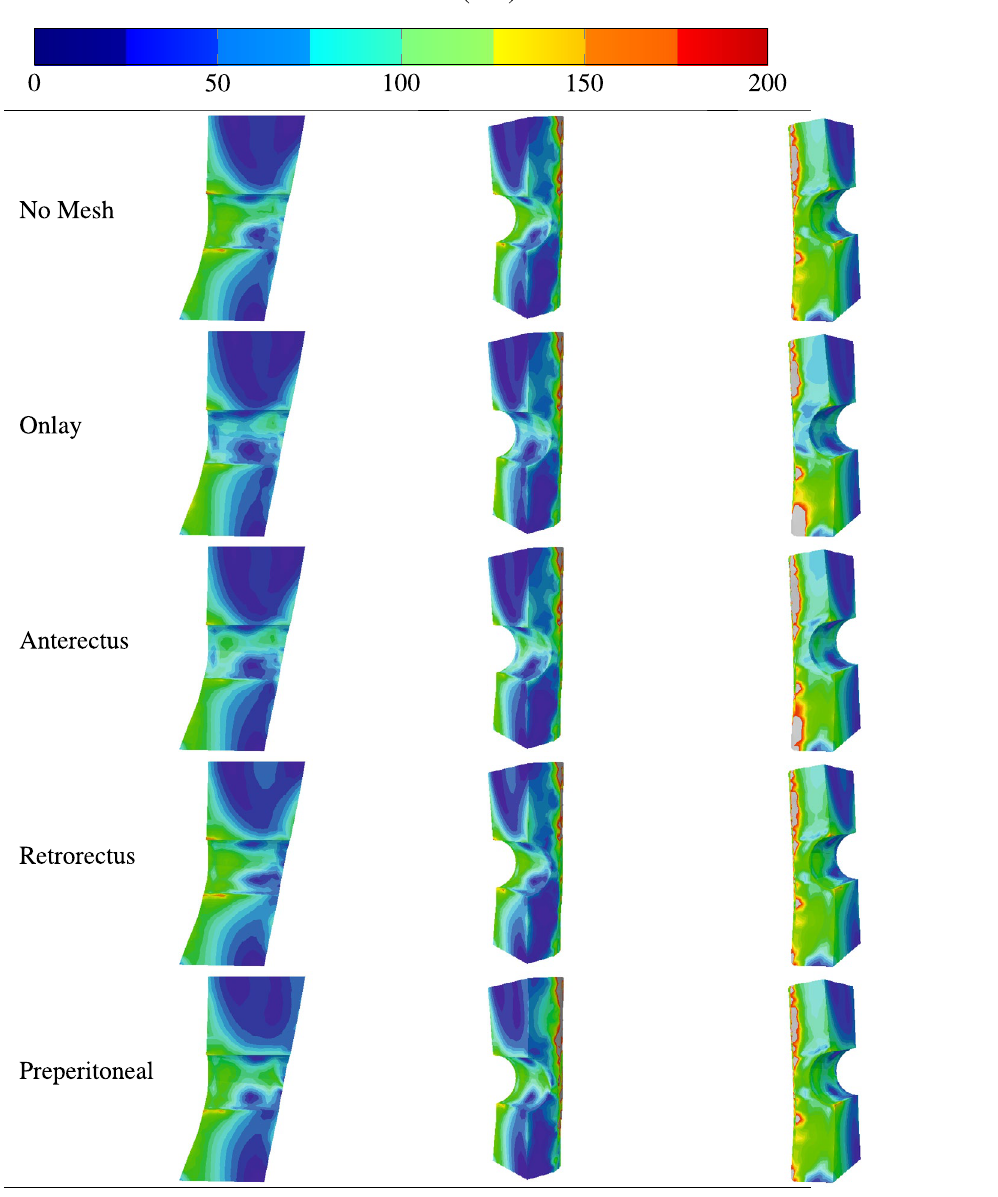
Figure 10. Contours of equivalent stresses in the linea albea affected by hernia when no mesh is applied (first row) and in the presence of a surgical mesh implants at the onlay plane (second row), anterectus plane (third row), retrorectus plane (fourth row), and at the preperitoneal plane (fifth